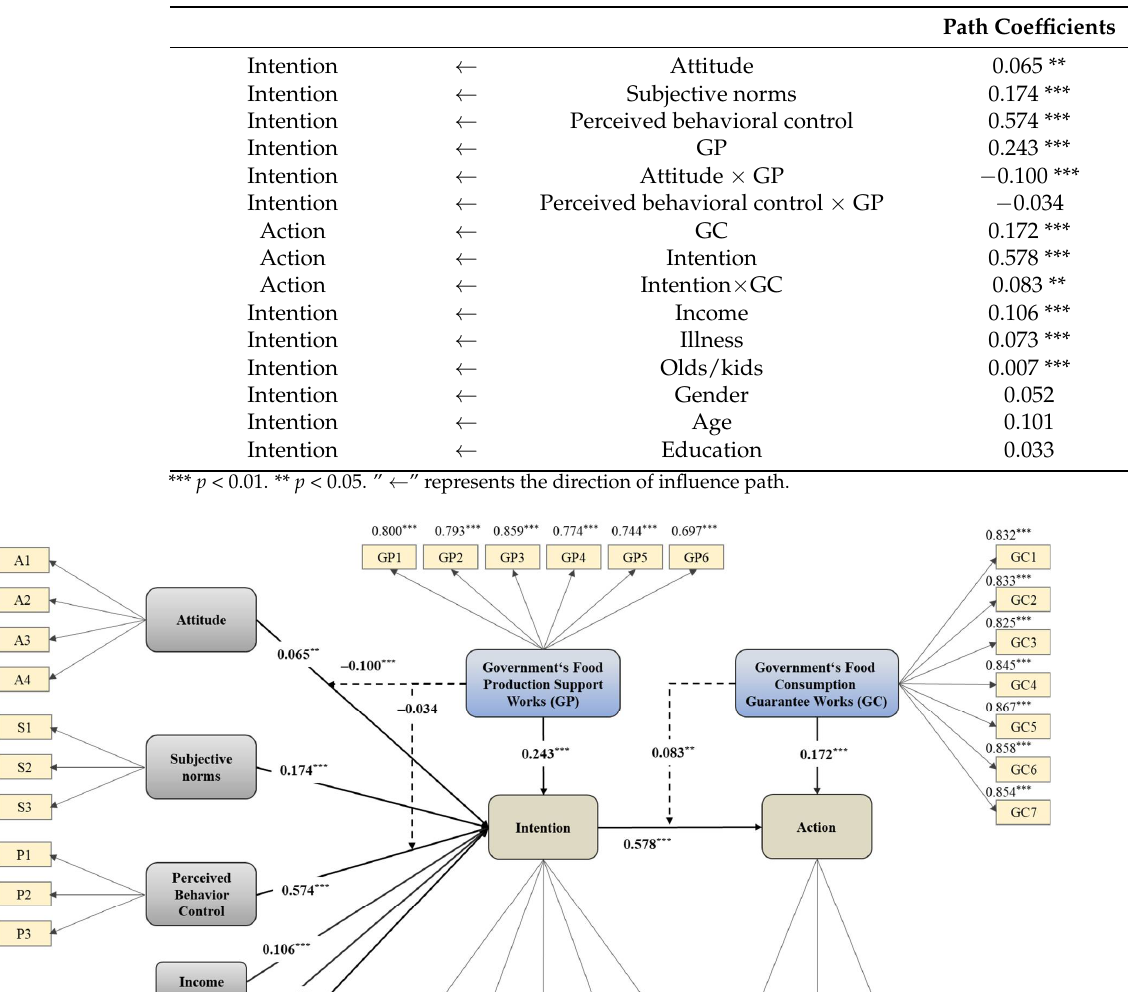
Table 5. Path influence coefficient and significance.